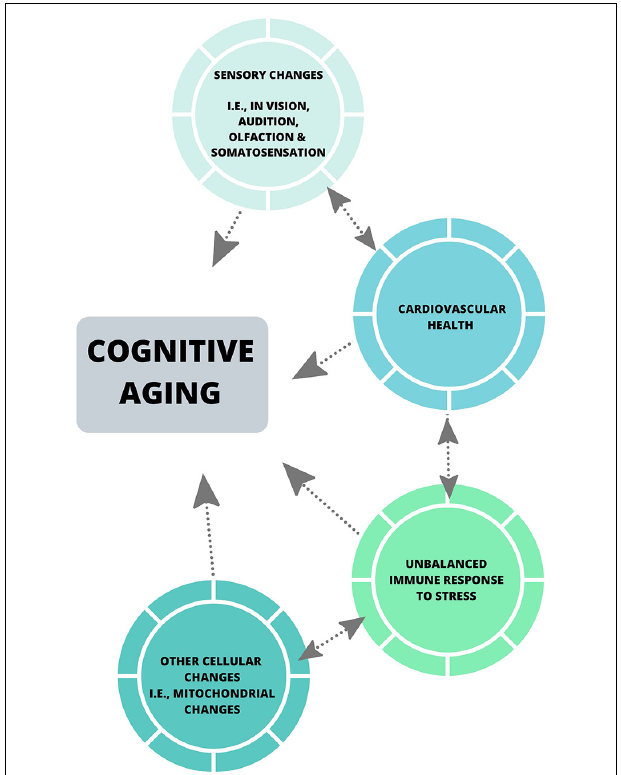
FIGURE 2 | A systems biological viewpoint of cognitive